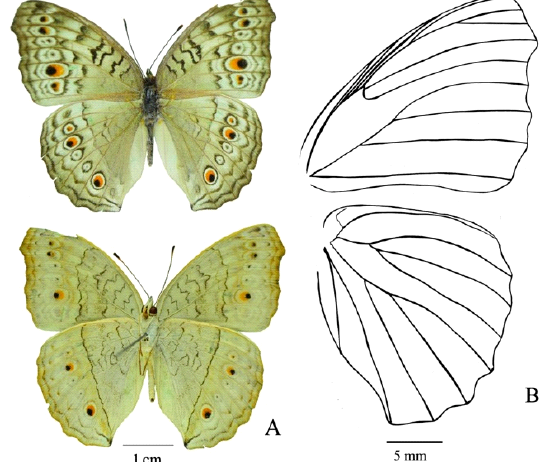
Figure 16. Junonia atlites (Linnaeus, 1763) A - Adult; B - wing venation.